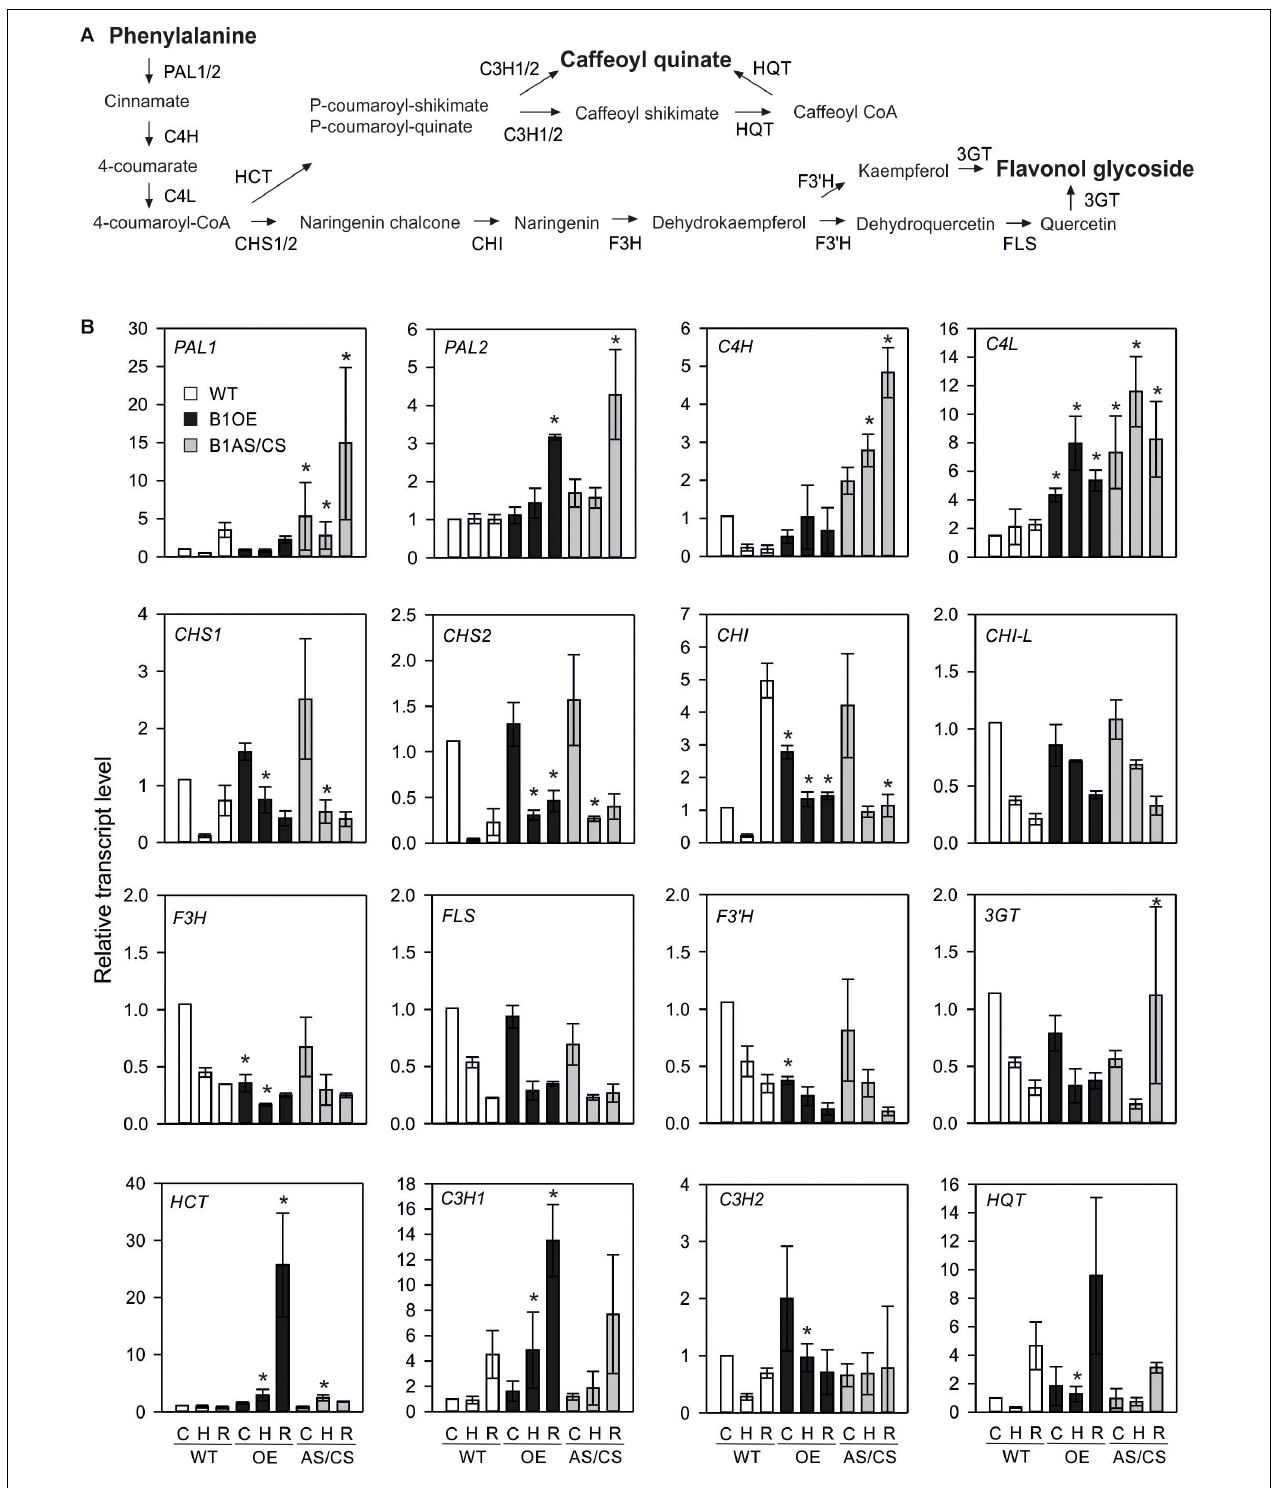
FIGURE 4 | Effect of HsfB1 overexpression and suppression on transcript levels of phenylalanine pathway (A) . Transcript levels (B) were determined by qRT-PCR and normalized to wild-type control sample for each gene. Values are the average for three independent OE lines (B1OE-5, -41, -46), and three independent suppression lines (B1AS-18, B1AS-21, B1CS-39), ± SE. Transcript levels are expressed relative to WT control sample. Asterisk denotes statistically significant difference ( p < 0.05) when compared to WT for the same temperature, based on paired t -test. Conditions: C, control; H, heat stress; R, recovery. Genotypes: WT, wild-type; OE, overexpression; AS/CS, antisense/co-suppression.